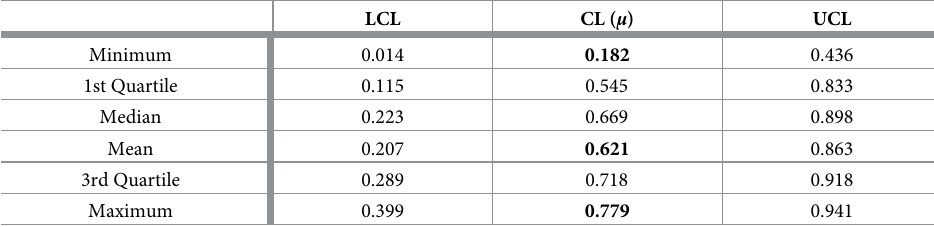
Table 5. Relative humidity’s summary statistics obtained from the UL regression analysis, given time-varying SPC, for its expected mean and boundaries.